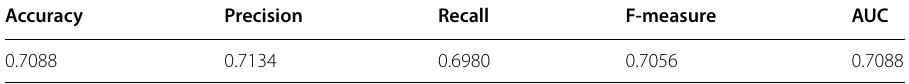
Table 1 Performance of the logistic regression on the StockTwits